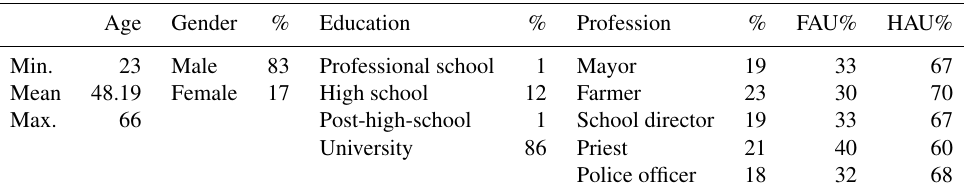
Table 1. Descriptive statistics of interviewees. FAUs represent administrative units dominated by floodplain areas, and HAUs represent administrative units dominated by hilly